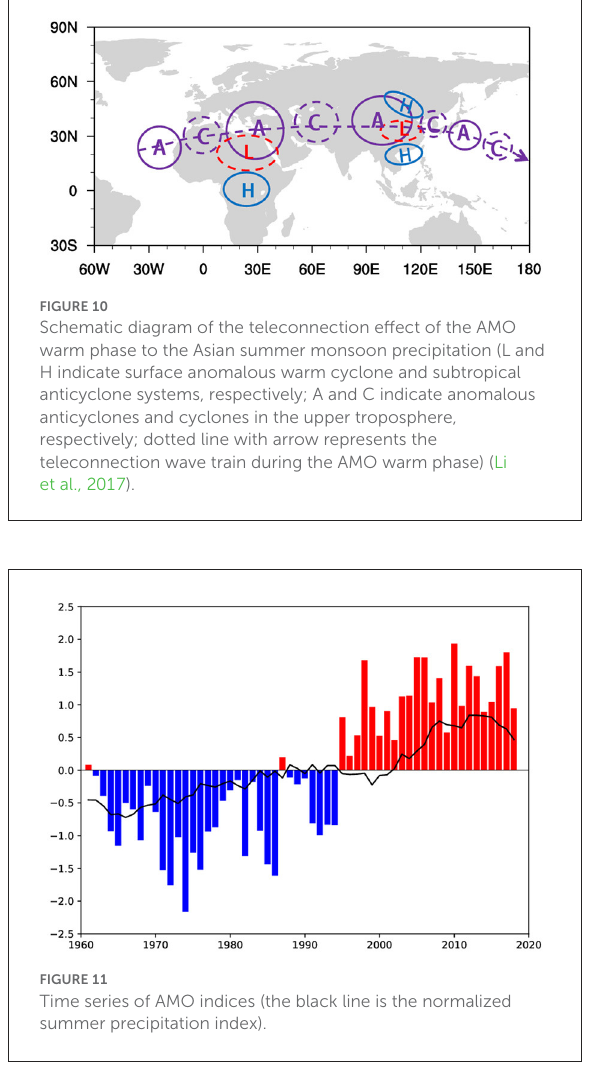
Li et al., 2017). AMO can affect its downstream region through